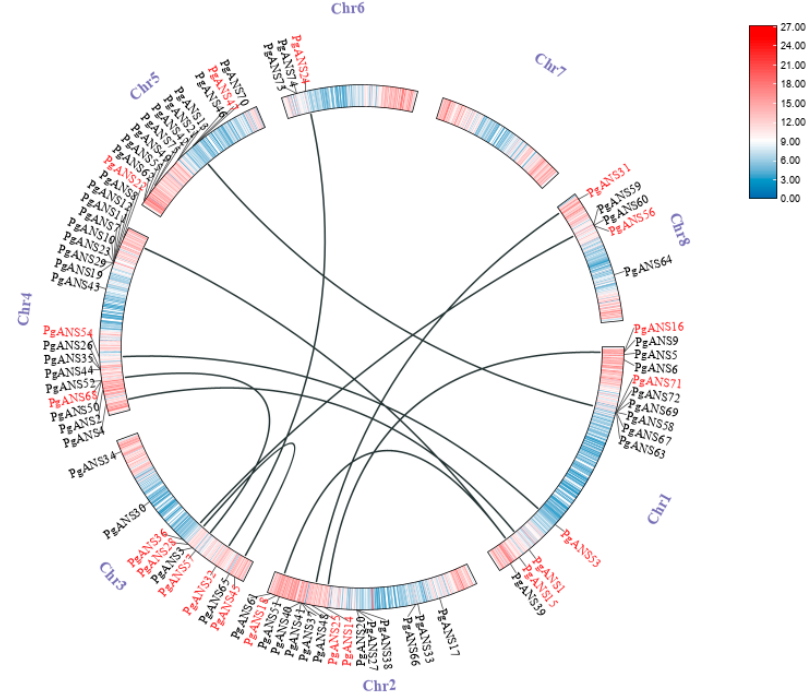
Figure 3. Location of the pomegranate ANS genes on the chromosome and gene duplication events. The red-colored names were the presence of co-linear genes.